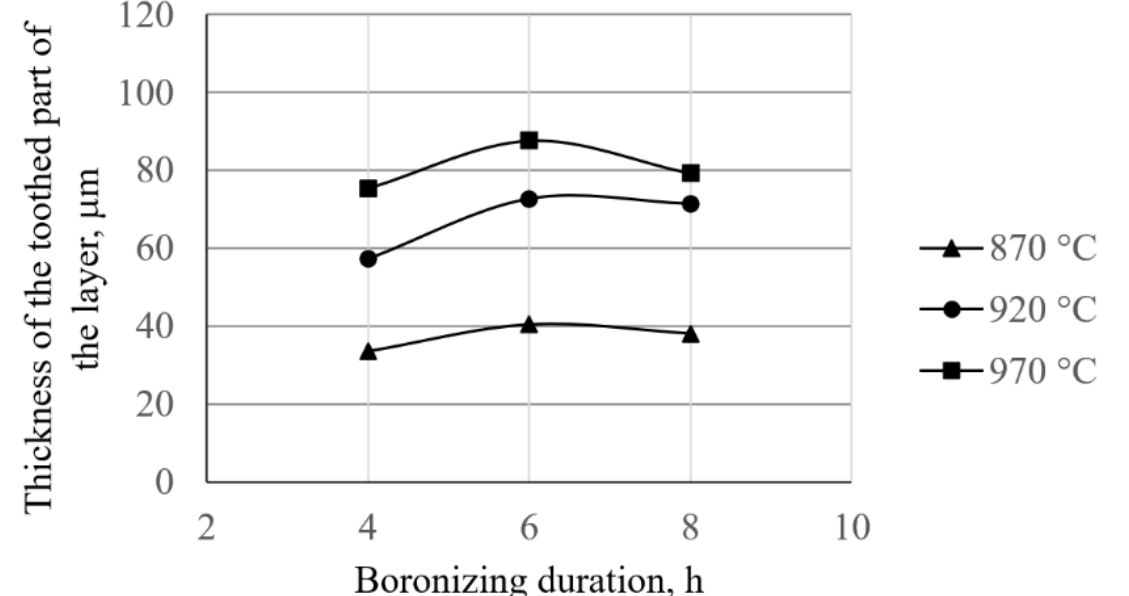
Figure 7. Dependence of the thickness of the toothed part of the boride layer on the temperature.